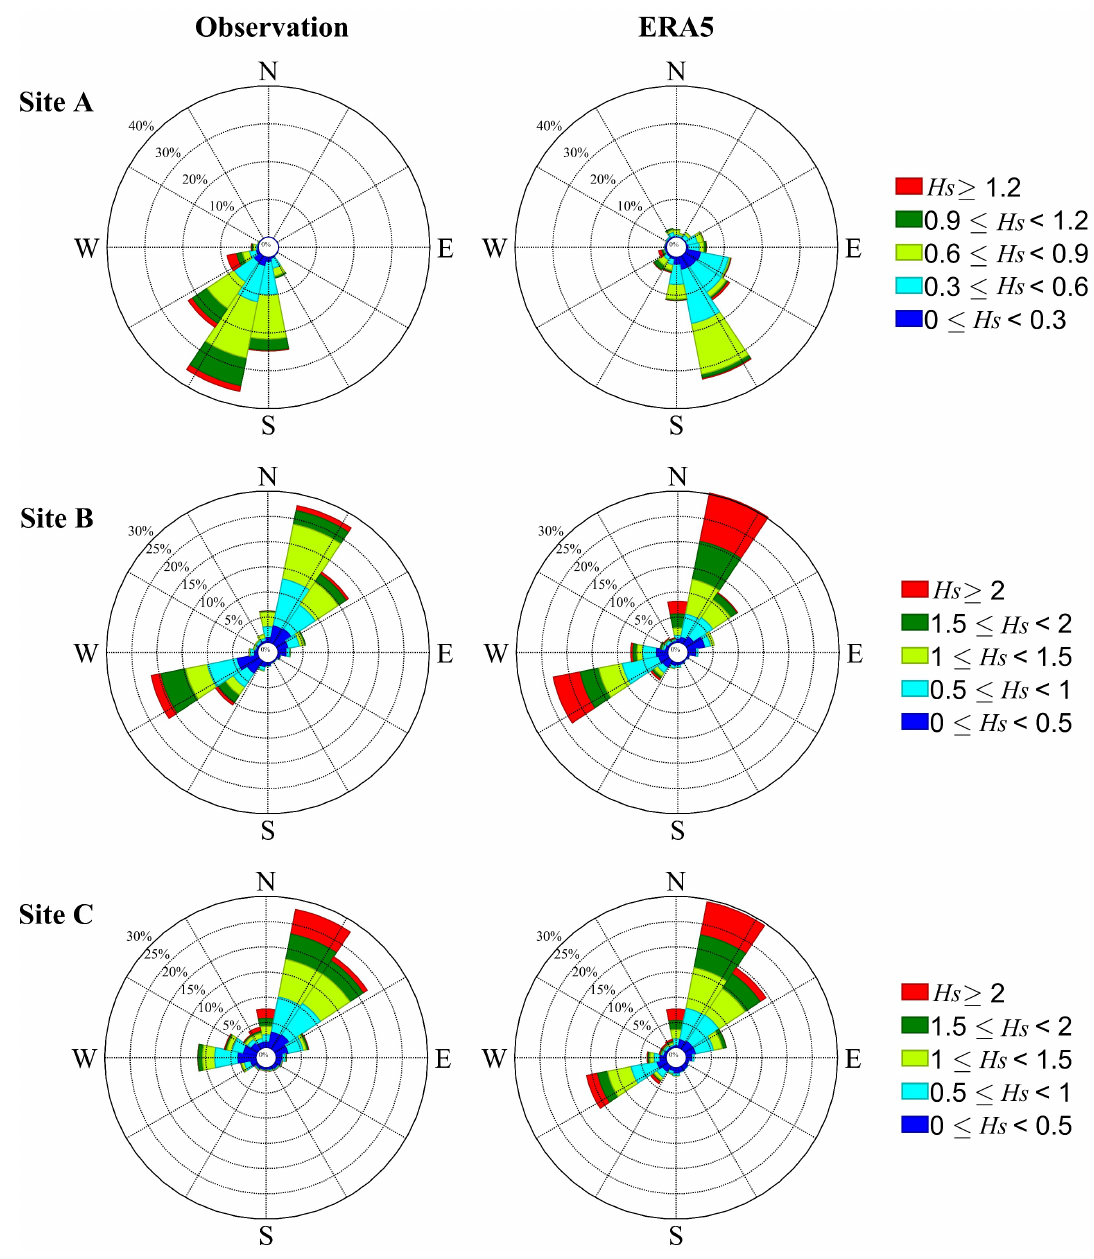
Figure 3. Comparison of wave roses between ERA5 model output and in situ measured data. The upper, middle, and lower panels display the results of Sites A, B, and C, respectively.